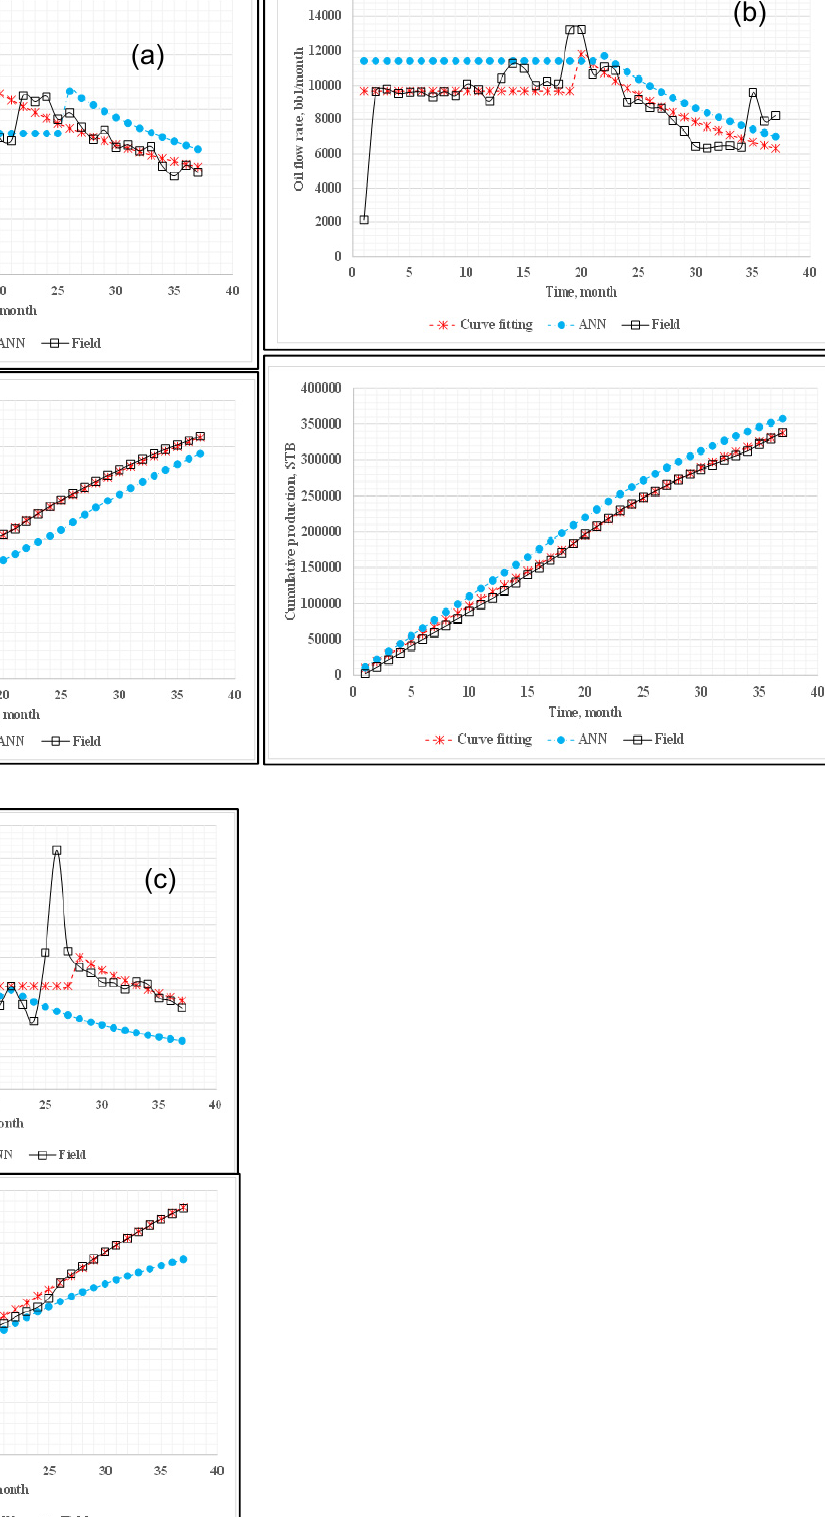
Figure 15. ( a ) Average quality case: average error in predicting curve fitting parameters is ~16.66%. ( b ) Best quality case: average error in predicting curve fitting parameters is ~9.86%. ( c ) Worst quality case: average error in predicting curve fitting parameters is ~18.59%.